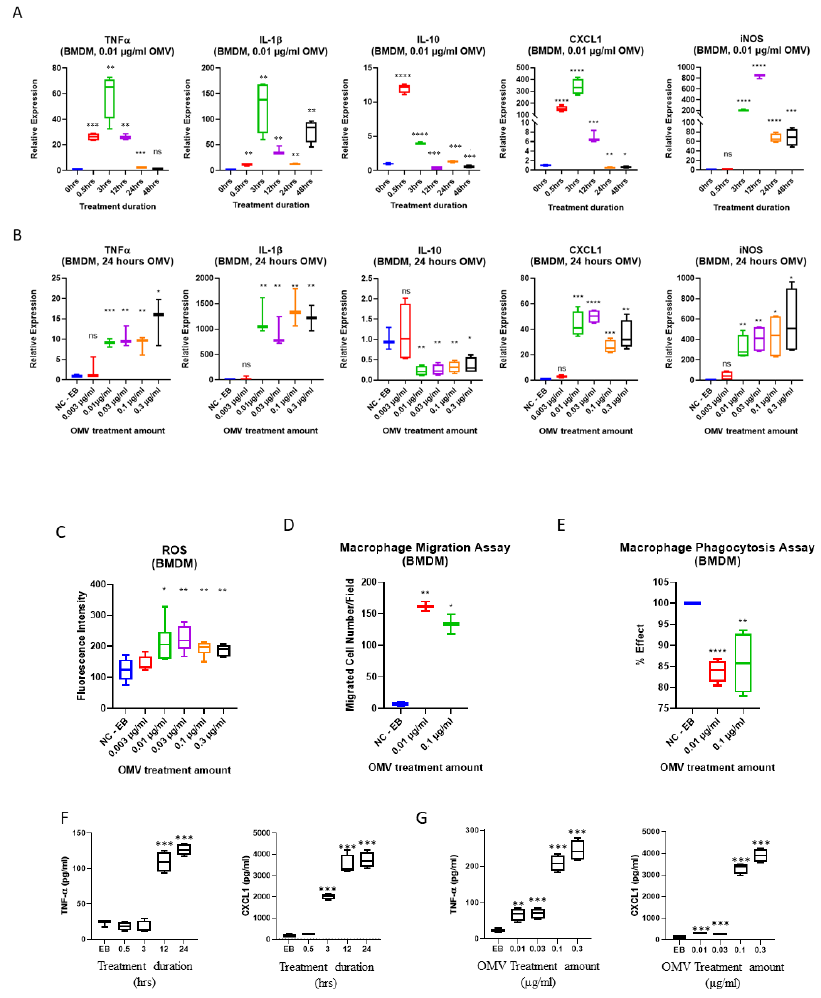
Figure 2. Effects of OMVs on BMDMs. ( A ) Effects of OMVs (0.01 µg/mL) on the cytokine and iNOS production in BMDMs (time course). ( B ) Effects of OMVs (24 h) on the cytokine and iNOS production in BMDMs (dose response). ( A , B ) Expression levels of TNFα, IL - 1β, IL -10, CXCL1, and iNOS were analyzed using real-time PCR. n = 3 or 4. TBP is used as the housekeeping gene. ( C ) Effect of OMVs on ROS production in BMDM. BMDM were treated with OMVs for 3 h with the indicated doses. Data represents n = 6. ( D ) Migration assay of OMV-treated BMDM. BMDMs were treated with OMVs (0.01 µg/mL or 0.1 µg/mL respectively). Migration assays were analyzed. ( E ) Effect of OMVs on Phagocytosis in BMDMs. ( D , E ) BMDMs were treated with the indicated amounts of OMVs for 24 h ( n = 4). ( F – G ) Time and dose dependent effect of OMVs on the production of proin- flammatory mediators in BMDM using ELISA. ( F ) Cells were treated for 0.5 h, 3 h, 12 h or 24 h in 0.01 µg/mL OMVs and ( G ) Cells were treated for 24 h in different concentrations of OMVs (0.01, 0.03, 0.1, 0.3 µg/mL). The sandwich-ELISA method was used to assess the secretory levels of proin- flammatory mediators TNF- α and CXCL -1 in the culture supernatant. Results were expressed as mean ± SD. Statistical Analysis was performed using two- tailed unpaired Student’s t -test. Mean ± SD is plotted ( n = 2 or 3). * p ≤ 0.005, ** p ≤ 0.001, *** p ≤ 0.0005, **** p ≤ 0.001 versus the control (0 hrs. in A, EB treated in B, C, D); EB- Elution Buffer, hrs.- Hour and ns-non-significant.